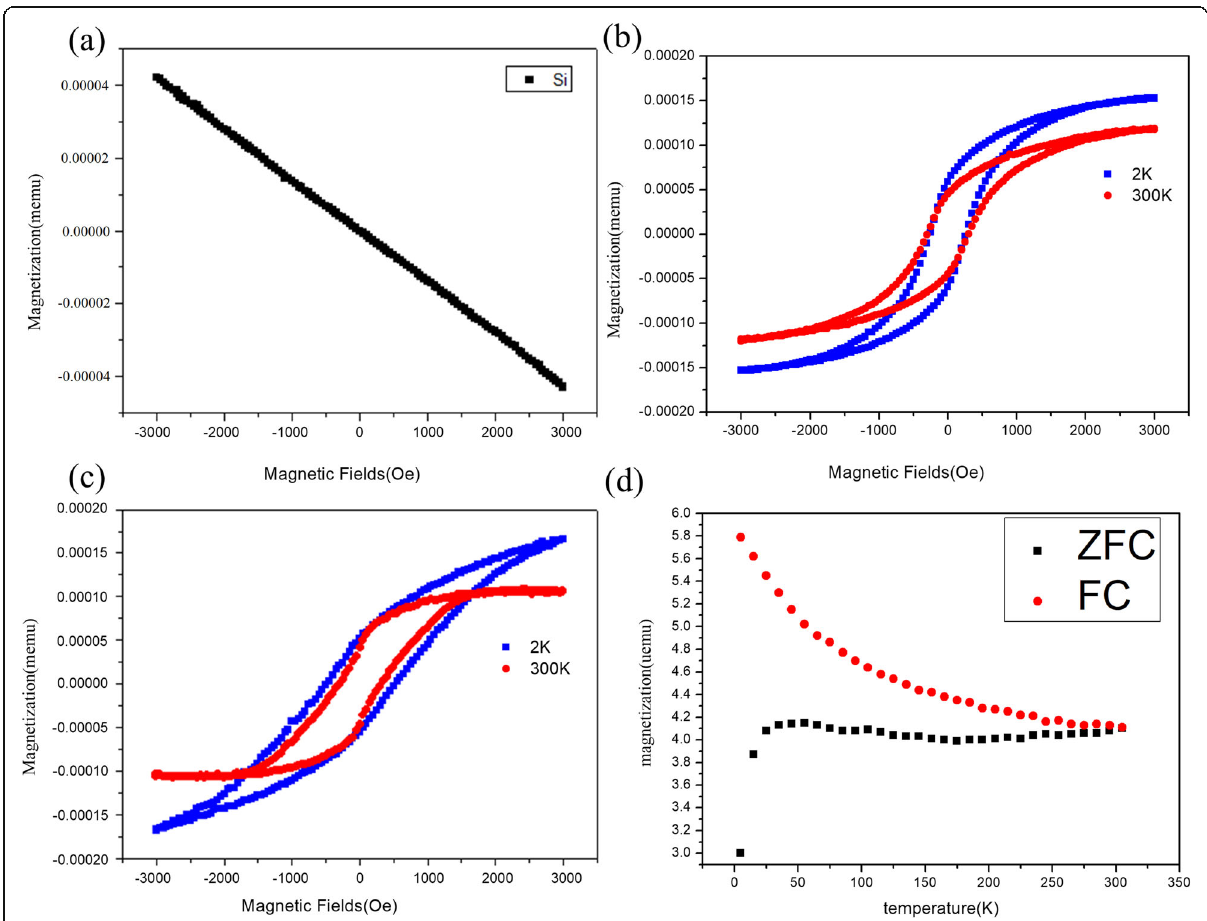
Fig. 4 a Magnetization measurements of the Si substrate. b Magnetization measurements of the shorter β -FeSi 2 nanowires at 2 K and 300 K. c Magnetization measurements of the longer β -FeSi 2 nanowires at 2 K and 300 K. d Temperature-dependent magnetization of the β